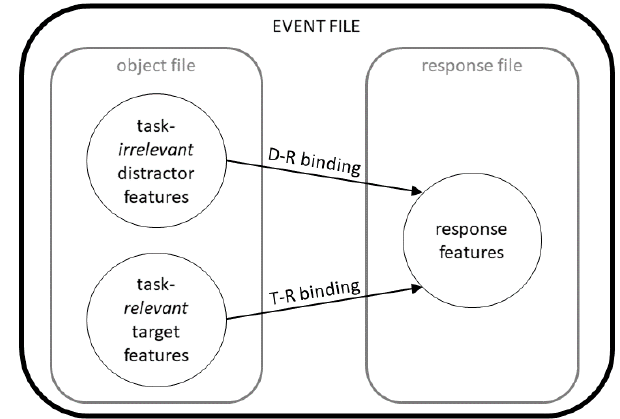
Figure 1. Schematic illustrations of the bindings postulated by the theory of event coding (TEC). Abbreviations: D-R = distractor-response; T-R = target-response.